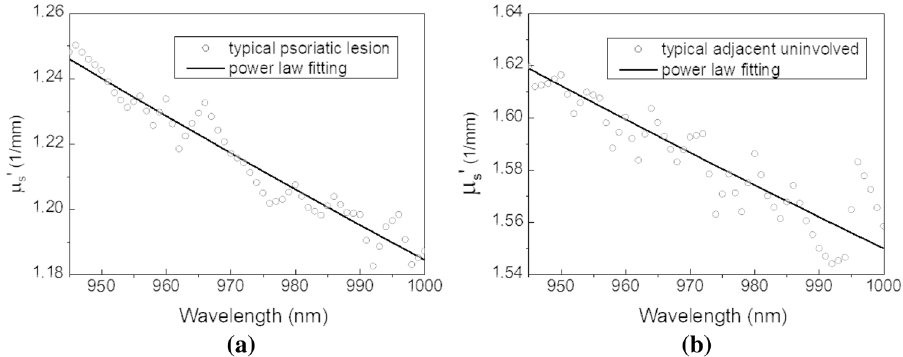
Figure 5. Typical skin reduced scattering spectra of psoriatic lesion site and its adjacent uninvolved site of the representative psoriasis subject at the “second overtone” of water absorption. The reduced scattering spectra of